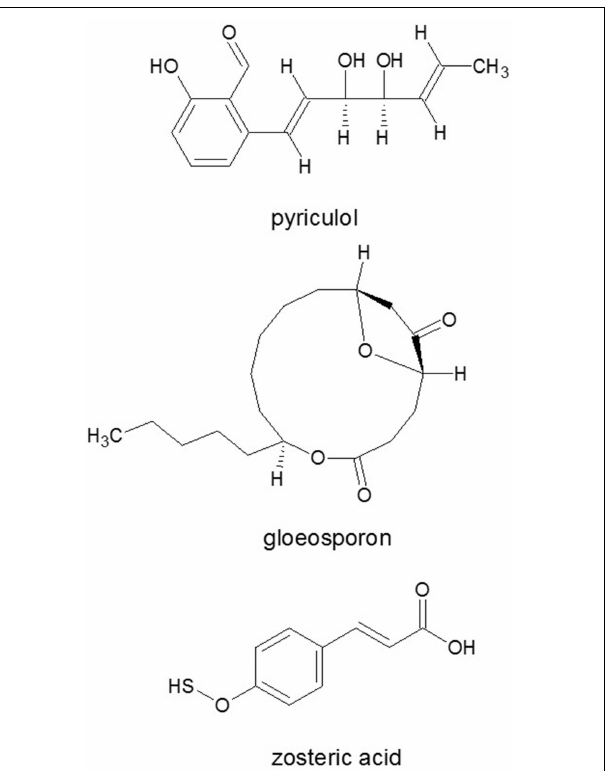
FIGURE 9 | Autoinhibitor signal molecules responsible for inhibition of conidia germination. Phytotoxin pyriculol and gloeosporone, and/or appressorium formation: zosteric acid. Source: National Center for Biotechnology Information. PubChem Compound Database (accessed Jun. 6, 2015) (Bolton et al.,